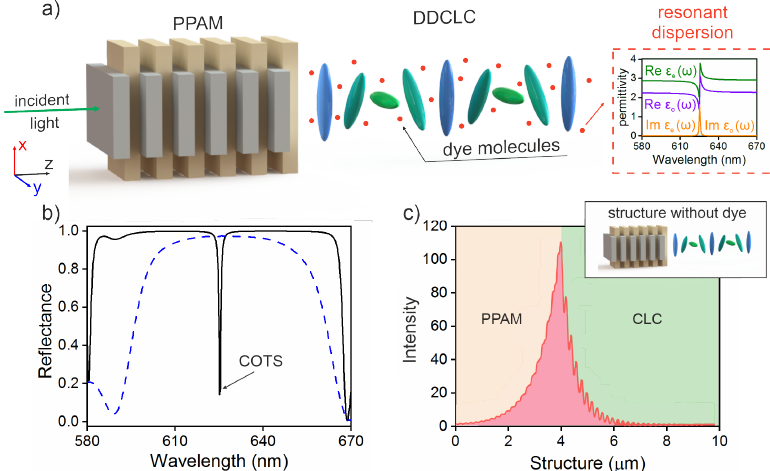
Figure 1. ( a ) Schematic of the structure consisting of a PPAM with length d and a DDCLC with length L . Inset: imaginary (yellow curve) and real (green and purple curves) are parts of the effective permittivity component of the DDCLC tensor. ( b ) Reflectance spectra of the PPAM-CLC structure. The solid curve corresponds to the diffracting polarization, i.e., the circular polarization that is reflected from CLC and the dashed curve, to the nondiffracting one. The PPAM length is d = 3.92 µ m, the period is Λ = d + d = 100 nm, d = 96 nm, the number of periods is N = 20, and the refractive V H , d V H PPAM indices are n p e = 1.7 and n p o = 1.5. The CLC layer length is L = 5.85 µ m, the number of periods is N CLC = 30, the helix pitch is p = 390 nm, and the extraordinary and ordinary refractive indices are n e = 1.7 and n o = 1.5. The CLC band gap center is λ 0 = 625 nm and φ = π /4. ( c ) Spatial distribution of the local field intensity in the sample corresponding to a COTS wavelength of λ = 625.3 nm normalized to the initial